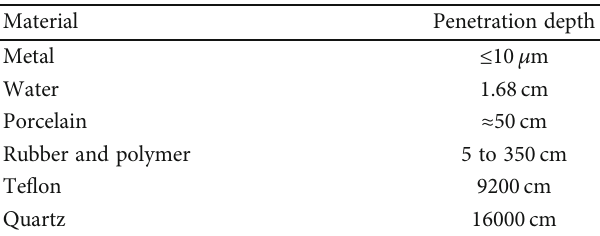
Table 1: Order of magnitude of the penetration depth for di ff erent materials at room temperature [15 – 17].